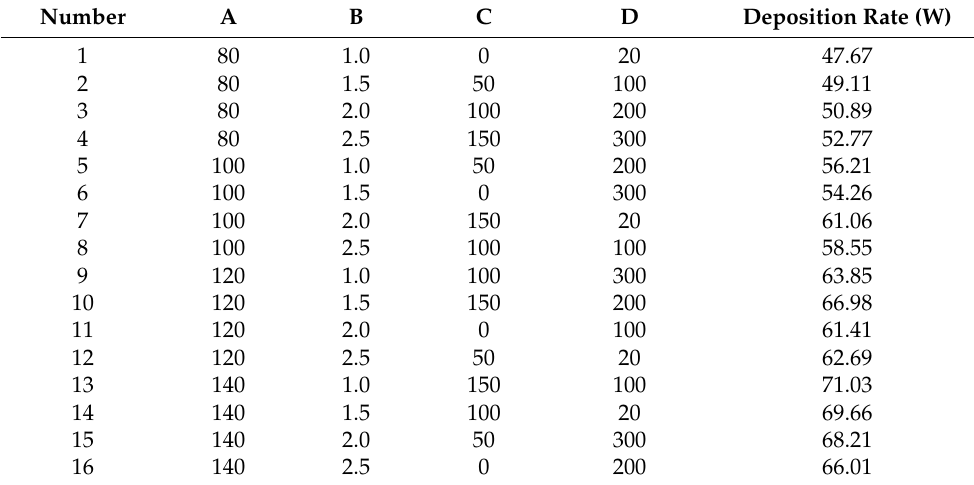
Table 6. L 16 (4 4 ) Orthogonal test design and results of Ni-Cr alloy film.